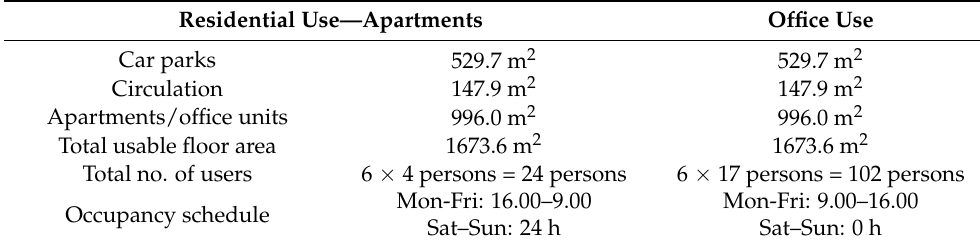
Table 3. Usable floor area schedules for residential and office use.